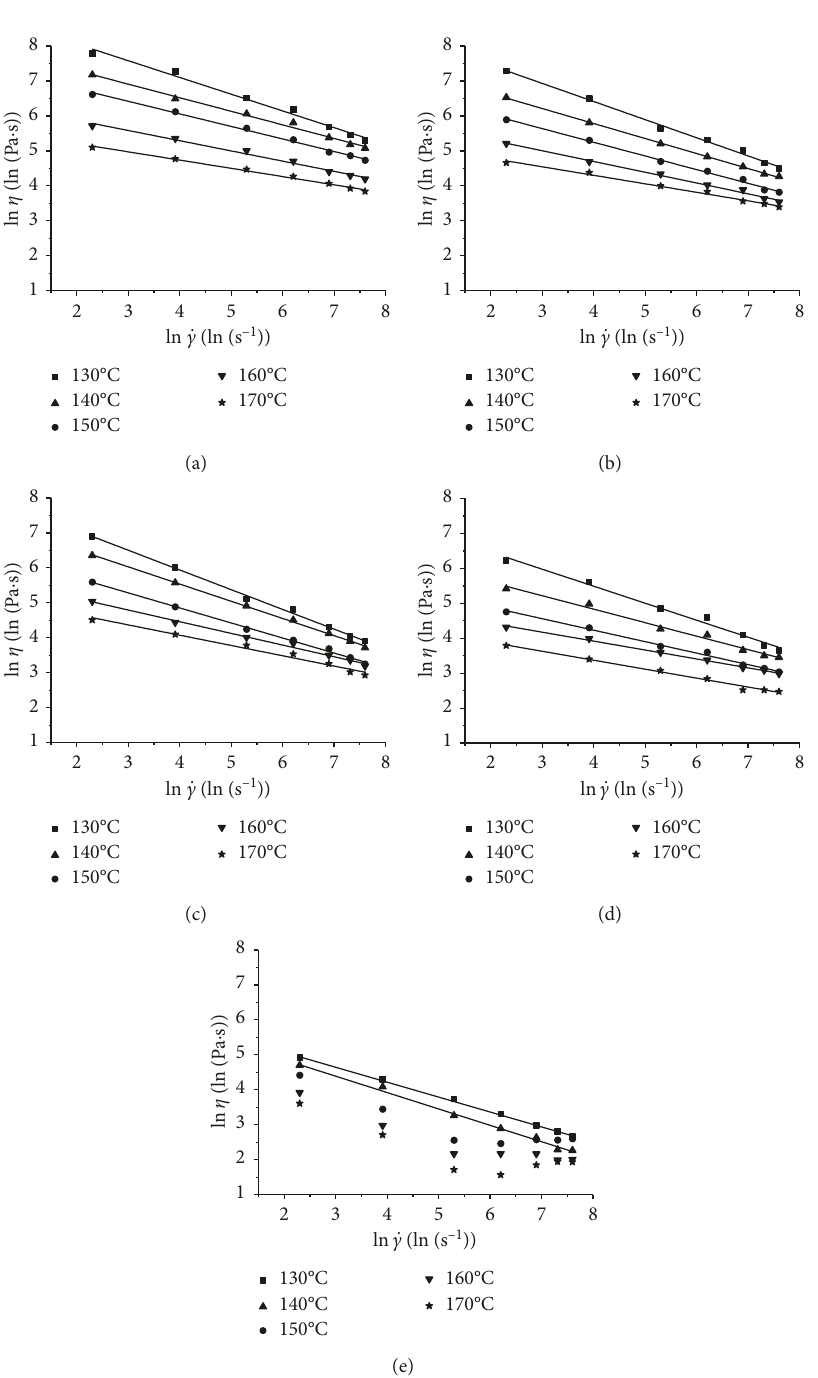
Table 3: Comparison of n , E , B , and η Binder content